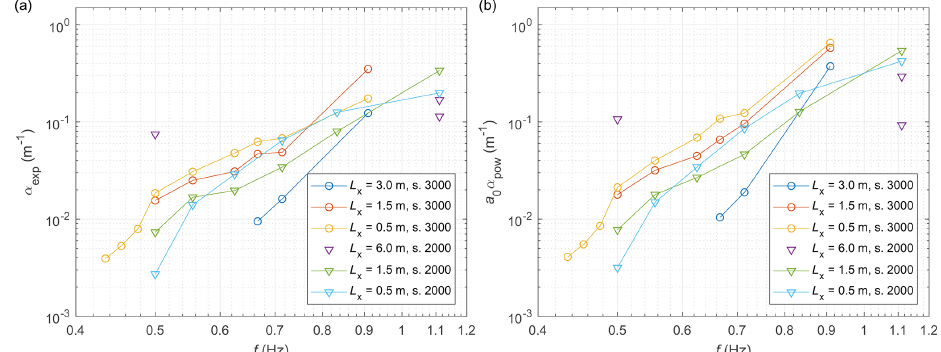
Figure 6. Attenuation rates (m − 1 ) in function of wave frequency f (Hz) obtained by fitting Eq. (4) (a) and Eq. (5) (b) to the observed LS-WICE data, with a 0 fixed at a 0 , w